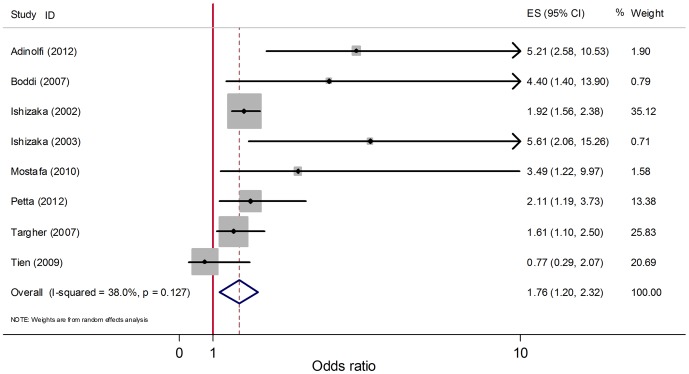
Forest plot for meta-analysis comparing adjusted OR of carotid atherosclerosis in HCV infected patients compared to that in non-infected controls.Eight studies reporting unadjusted ORs were included. Unadjusted ORs from the included studies and the pooled OR are shown. Dimension of shaded OR for individual studies is proportional to their total weight in calculation of the pooled estimator.